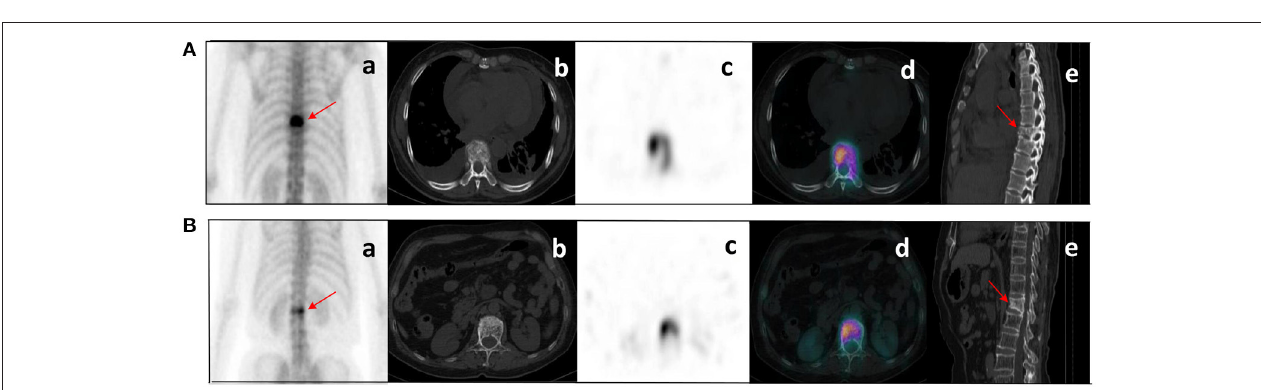
FIGURE 6 | Clinical cases SPECT/CT images of bone metastases (A) and benign bone lesions (B) . The images shown are WBS image, axial CT, SPECT, fusion image, and sagittal CT (a–e, respectively). (A) bone metastases: a 53-year-old female with an adenocarcinoma of the left lung. Wedge-like changes of the T8 vertebral body with an abnormal concentration of radioactive tracer (arrows). (B) benign bone lesions: a 68-year-old female with breast cancer. Wedge-like changes of the L1 vertebral body with higher bone density and increased radioactive tracer distribution (arrows). It was difficult to determine whether lesions were metastasis with conventional images only. Lesion (A) was confirmed as pathological fracture due to bone metastases by pathological examination and showed systemic bone metastases at subsequent imaging follow-up. Lesion (B) was confirmed to be a benign compression fracture by imaging follow-up and clinical information.